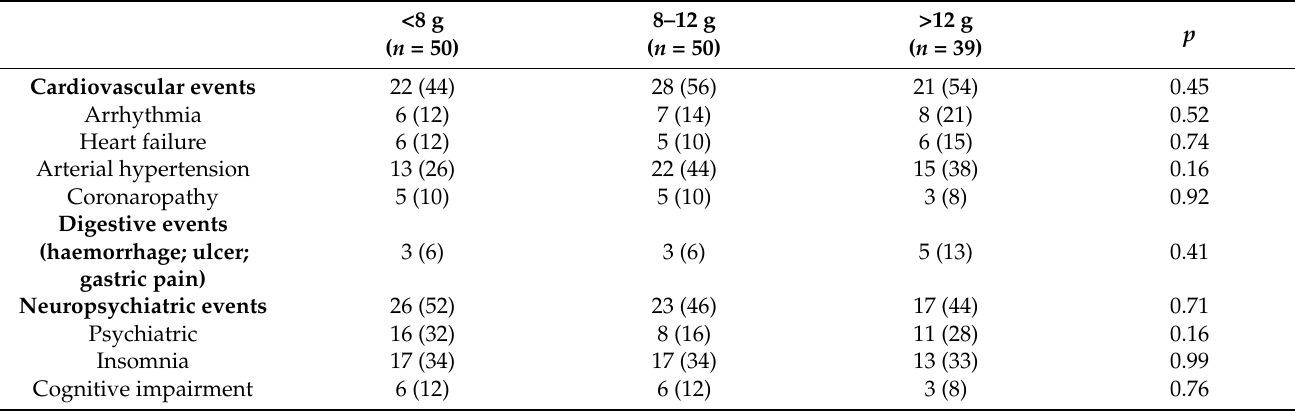
Table 3. Glucocorticoid-related AEs in GCA patients according to three groups of GC cumulative